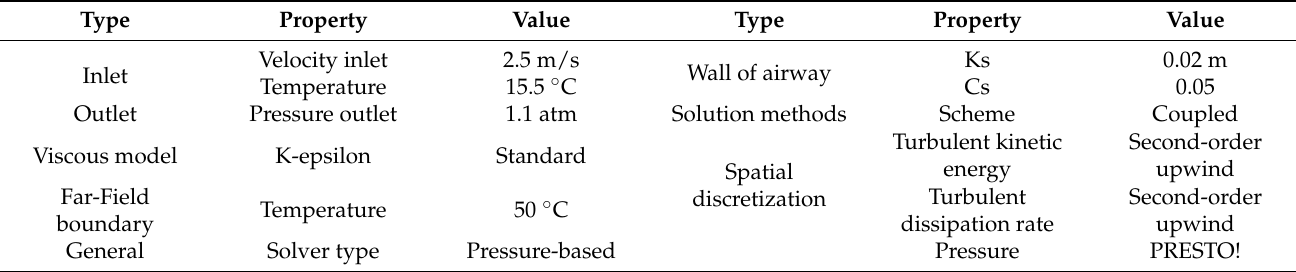
Table 7. Setting of simulation parameters.